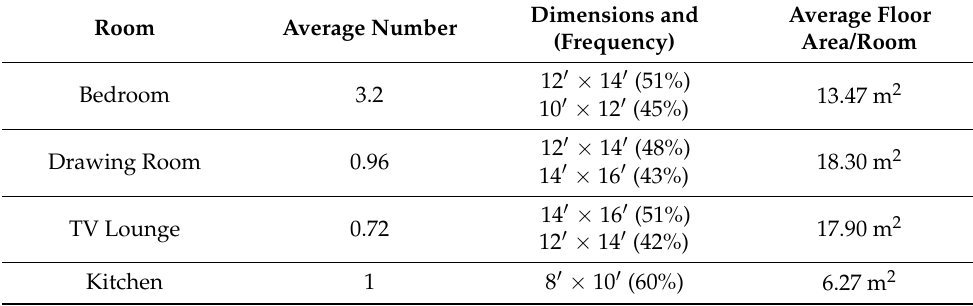
Figure 3. Percentage distribution of average floor area of a typical house in Mirpur city. Table 1. Average floor